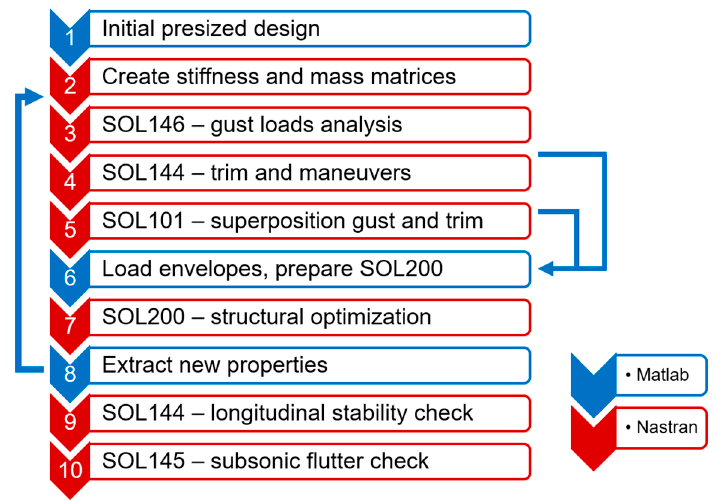
Figure 11. Workflow of loads analysis and structural optimization.